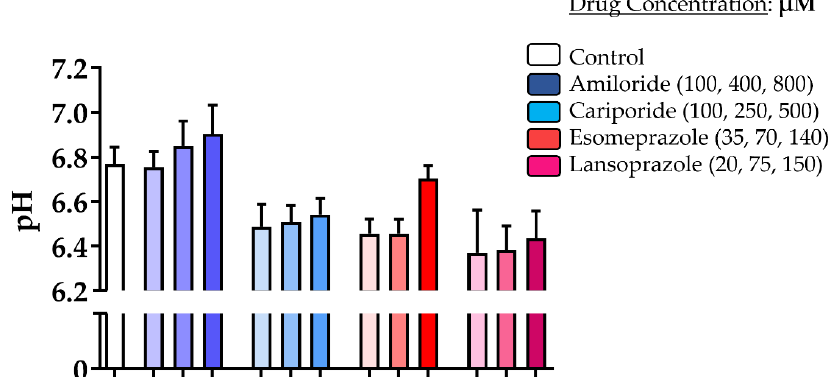
Figure 2. Impact of proton pump inhibitors on extracellular pH. Measurement of culture media pH values for DU145 prostate cancer cells upon incubation for 24 h in normoxia with Amiloride, Cariporide, Esomeprazole, and Lansoprazole (blue, light-blue, orange and pink bars, respectively) at increasing concentrations (associated with darker colors of the bar columns) compared to control cells (white column bar on the left).